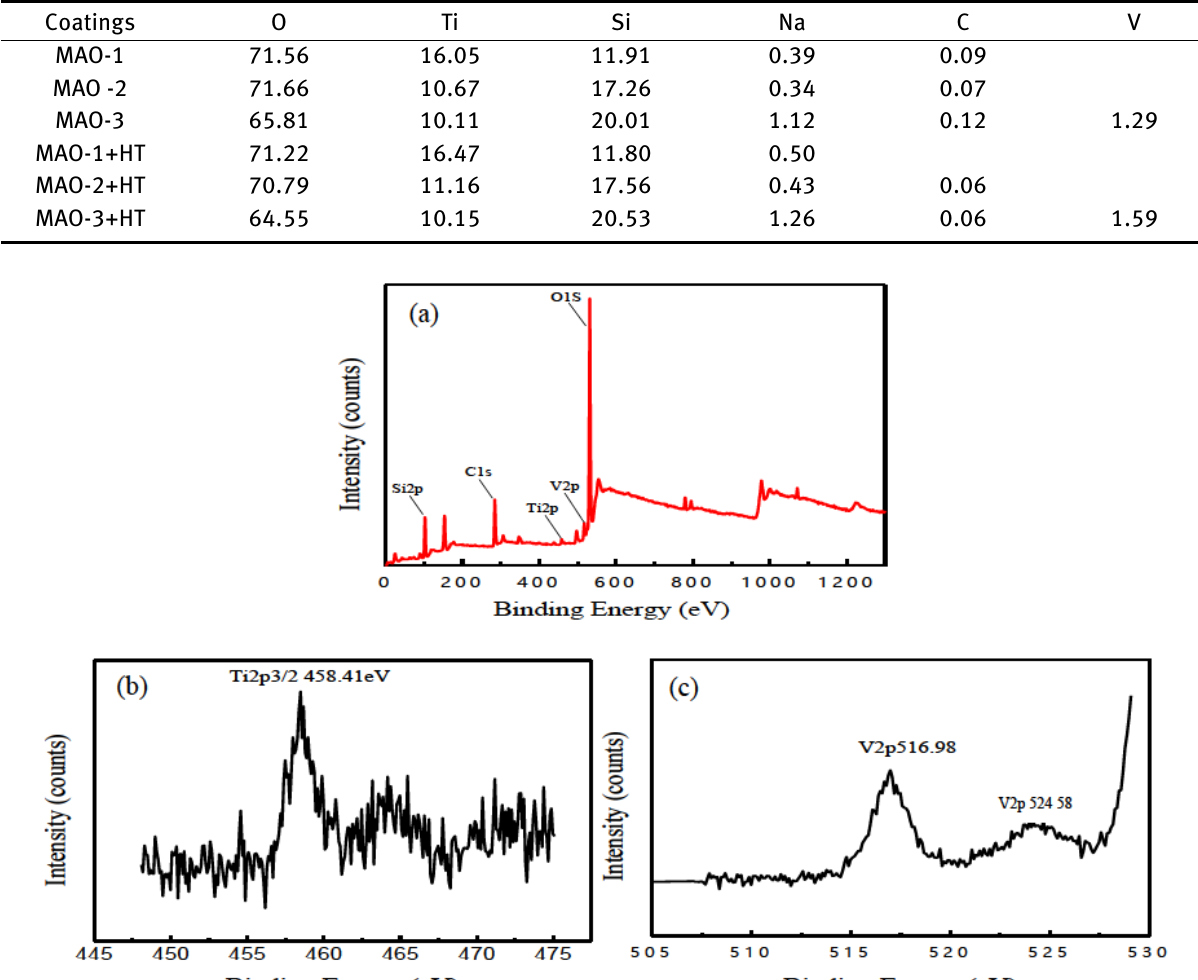
photocatalytic performance due to the increase of surface